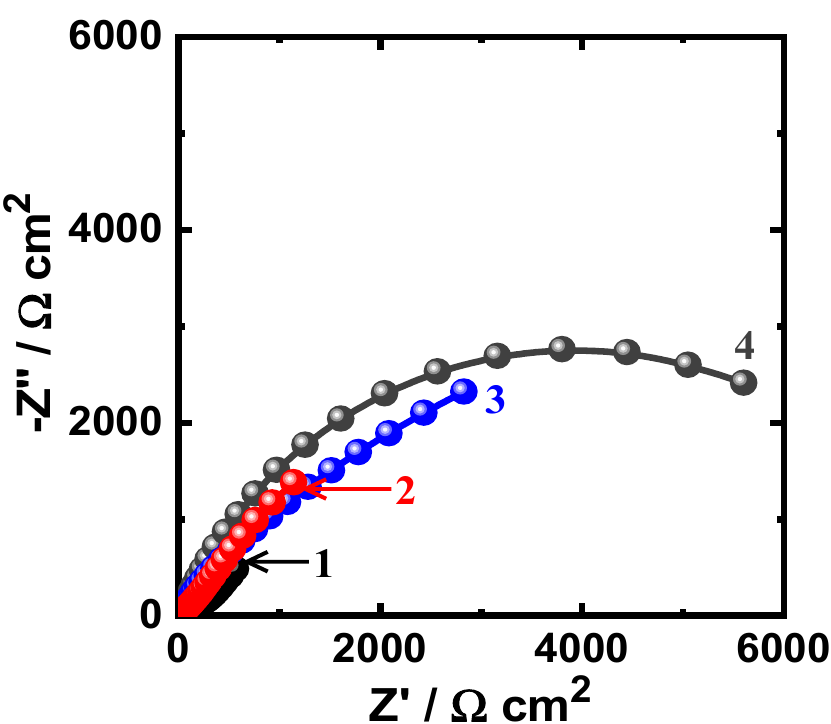
Figure 8. Nyquist spectra for iron after its exposure for 1 h to (1) 3.5% NaCl solutions in the absence and presence of (2) 5 × 10 − 5 M MAO, (3) 1 × 10 − 4 M MAO, and (4) 5 × 10 − 5 M MAO, respectively.